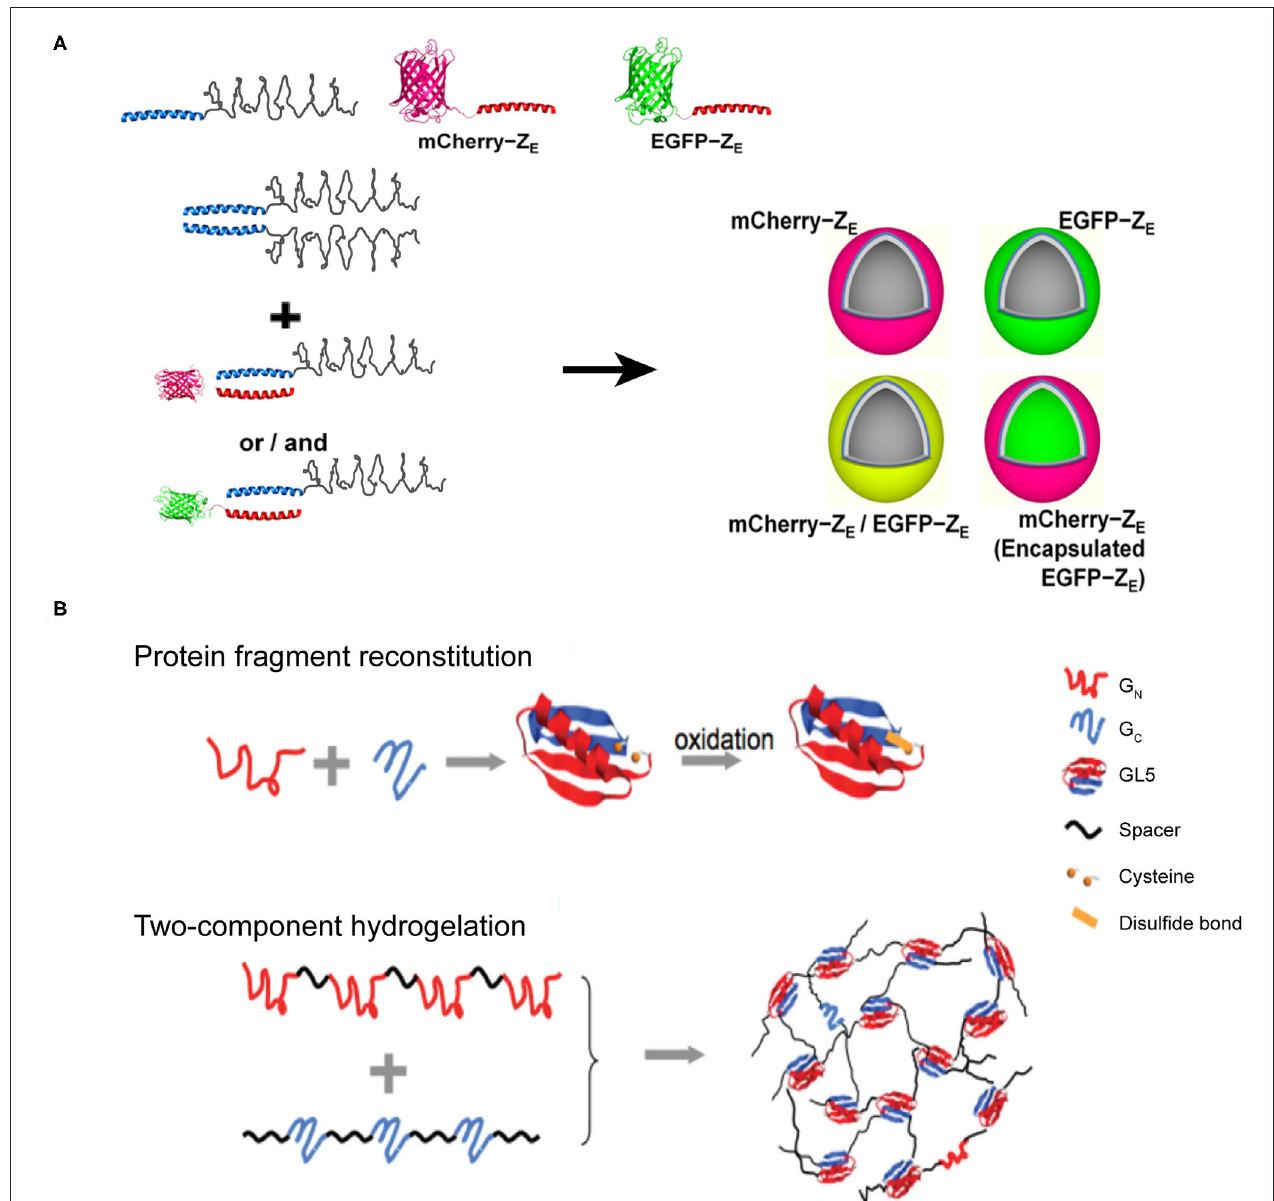
FIGURE 7 | Self-assembled 3D protein superstuctures generated by amphiphilic protein and protein fragment complementation directed protein assembly. (A) Recombinant protein amphiphiles and their self-assembly into vesicles. Reproduced with permission from Park and Champion (2014). Copyright 2014 American Chemical Society. (B) Formation of reconstituted GL5 from GN and GC (Top) and the schematic of fragment complementation induced two-component hydrogelation. Reproduced with permission from Kong and Li (2015). Copyright 2015